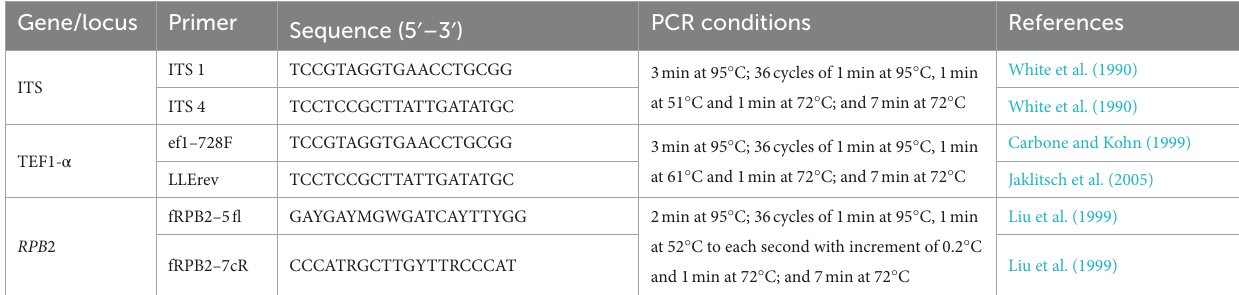
TABLE 1 PCR primers and conditions used for DNA